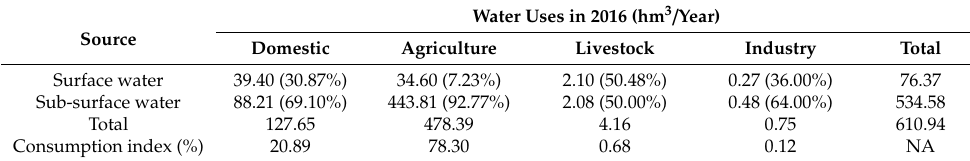
Table 4. Withdrawals from surface and underground waters and overall water use in Crete. Source: [15].